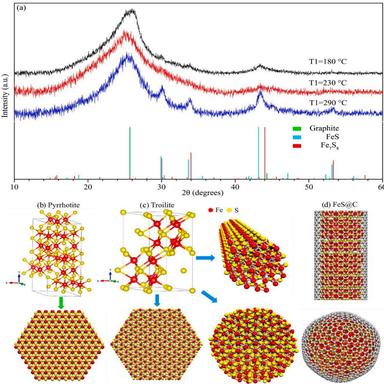
Cristina L. Rodríguez-Corvera et al. (a) XRD patterns obtained from samples synthesized at T1 = 180 ◦C, 230 ◦C, and 290 ◦C. The signals of the crystallographic planes for graphite (PDF 01–077-7164) and pyrrhotite-Fe7S8 (PDF 00–024-0220) are indicated. Ball-stick models showing the unit cells of (b) pyrrhotite-Fe7S8 and (c) troilite-FeS. In (b), a = b = 6.867 Å, c = 17.062 Å, α = β = 90◦, and γ = 120◦. In (c), a = b = 5.965 Å, c = 11.759 Å, α = β = 90◦, and γ = 120◦. Different nanostructures derived from pyr